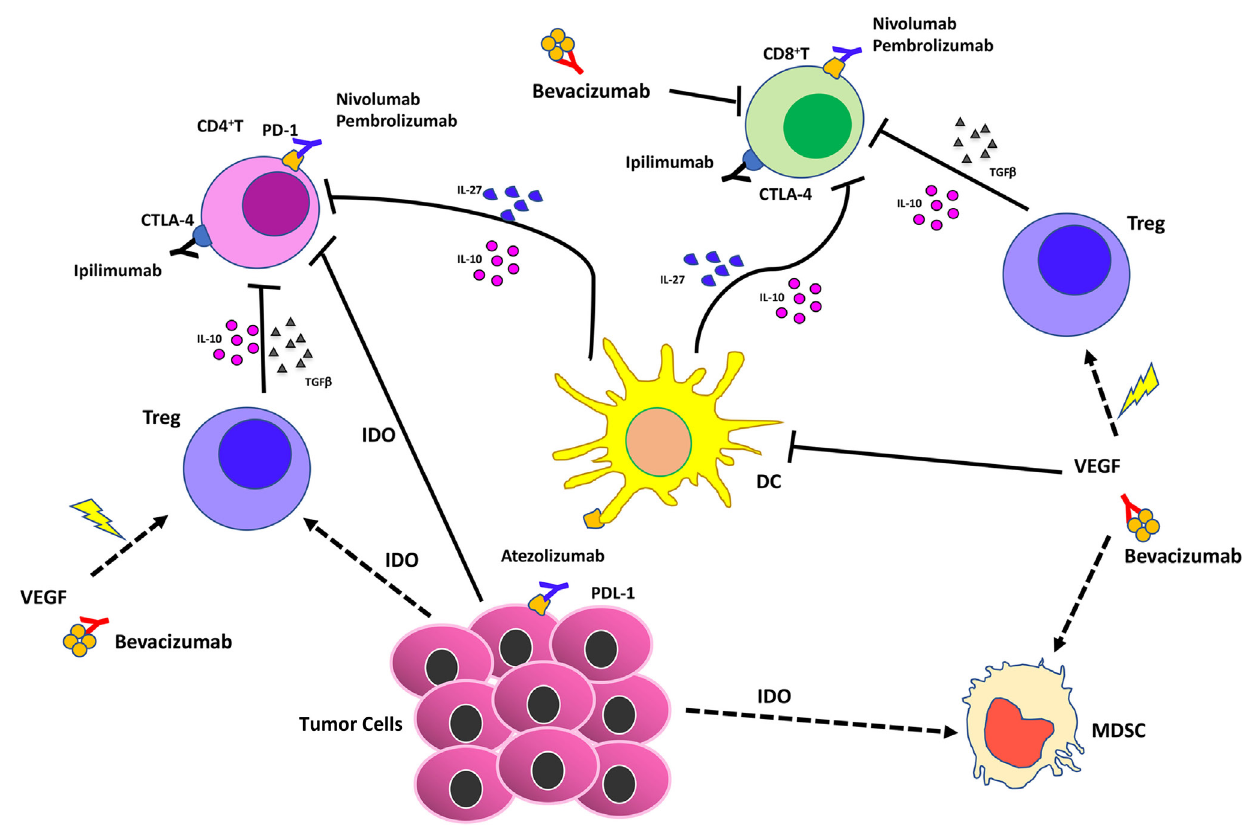
FigURe 4 | Effects of vascular endothelial growth factor (VEGF) inhibition combined with immunotherapy in the tumor microenvironment. Immune checkpoint blockers (ICBs) combined with antiangiogenic drugs act synergistically on different cell of innate immunity by (i) reducing VEGF in the tumors that supports angiogenesis; (ii) supporting vascular normalization to stabilize blood vessels and enhance therapeutic agent delivery, T cell infiltration, and activation; (iii) blocking dendritic cells, myeloid-derived suppressor cells, T regulatory (Treg)-mediated